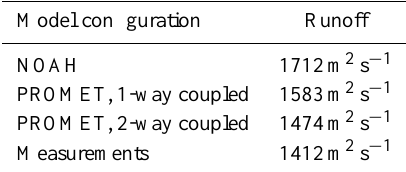
Table 1. Measured annual mean runoff at the outlet of the Up- per Danube catchment at Achleiten in comparison with simulated runoff of NOAH/MM5 and PROMET/MM5 in either 1-way or 2- way coupled